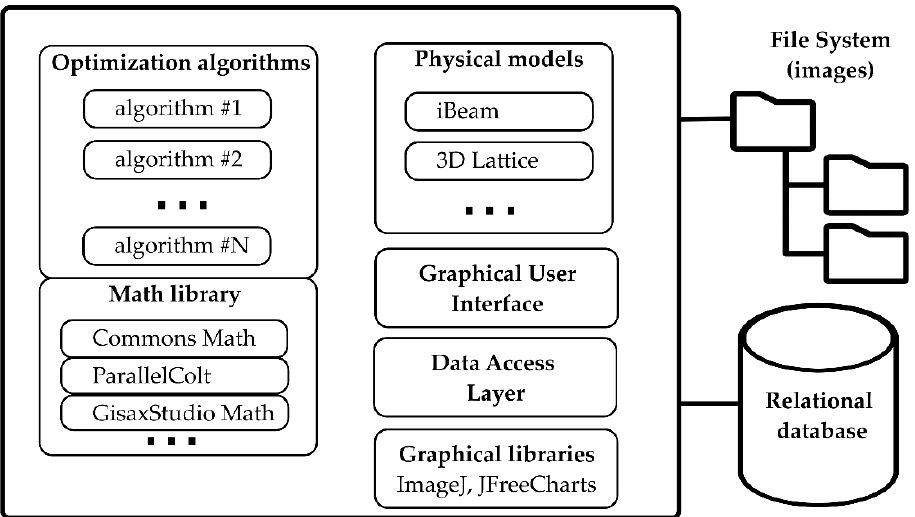
Figure 1. GisaxStudio architecture. Physical models are decoupled from the generic optimization algorithms. Images are stored in file system, and project data is stored in a JDBC-compliant relational